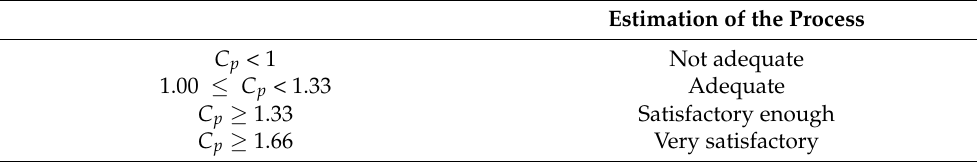
Table 10. Process capacity evaluation index.